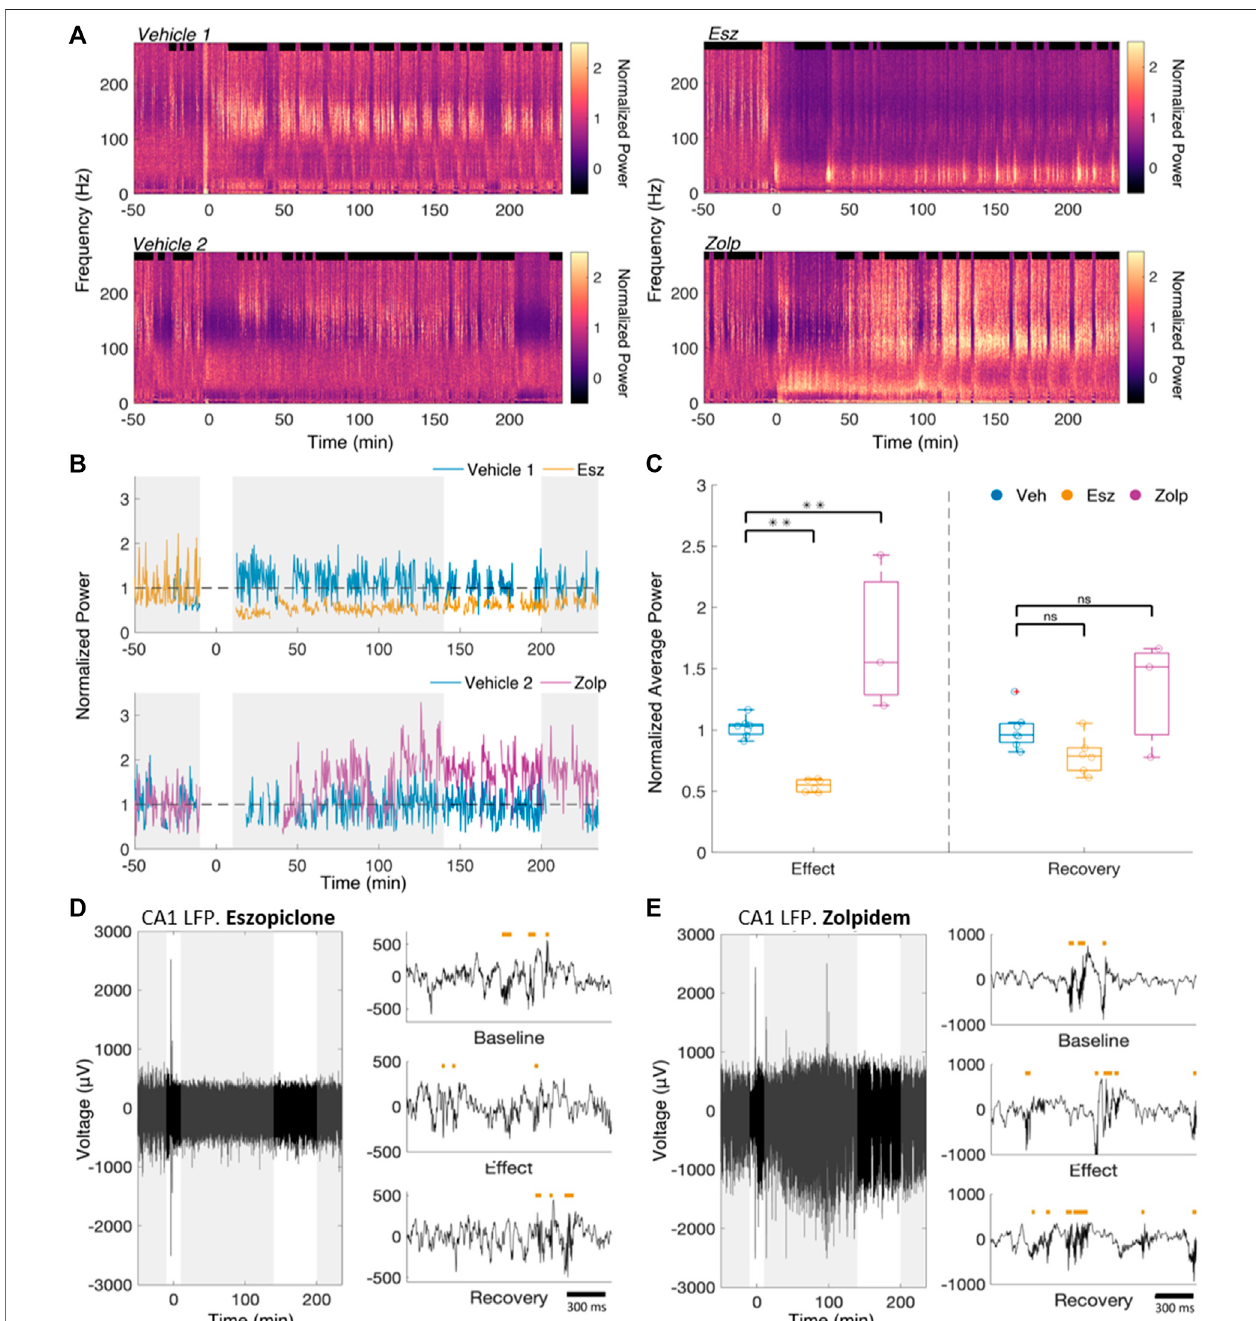
FIGURE 1 | Eszopiclone and zolpidem have differential effects on CA1 power in the ripple band. (A) Raw spectrogram of the CA1 LFP for a pair of vehicle and eszopiclone sessions (top) and vehicle and zolpidem sessions (bottom) from the same rat. Drug (10 mg/kg) or vehicle was injected at time 0. (B) Average normalized ripplepower(100 – 200 Hz)duringsleepforthespectrogramsin Figure1A .Grayboxesindicatetimewindowsofinterest (fromlefttoright: Baseline,Effect,Recovery ) . Effects near the injection ( t (cid:1) 0) were ignored. (C) Boxplots (each circle one session) of the ratio of average normalized sleep ripple power (100 – 200 Hz), within “ Effect ” and “ Recovery ” relative to the “ Baseline ” . Signi fi cance was determined using an F-test on a fi tted mixed linear model ( n (cid:1) 4 rats; see Supplementary Table S2 for details). (D) Example raw CA1 LFP recordings from a session inwhich eszopiclone wasinjected, alongwith detected ripples (red bars) within the three timewindows of interest (top, Baseline; middle, Effect; bottom, Recovery). (E) Same for zolpidem session.